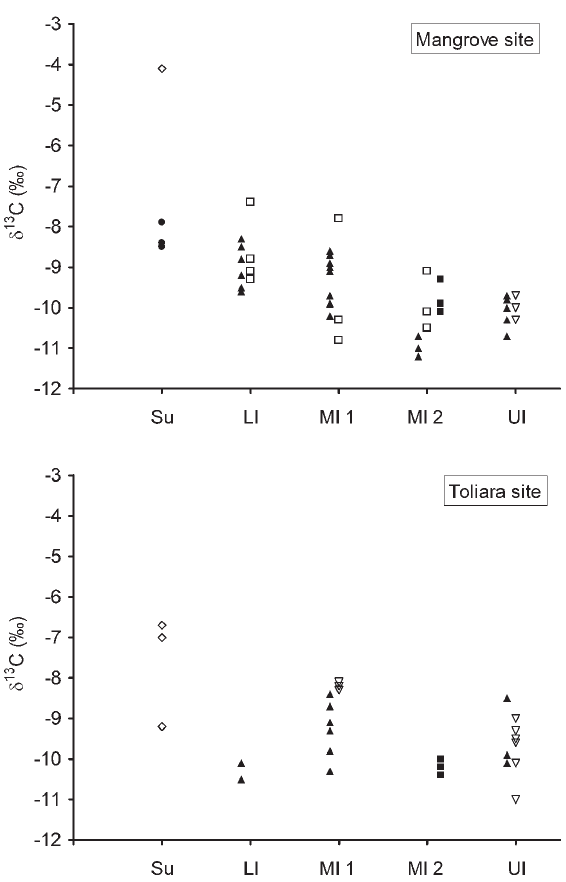
Fig . 4. – carbon isotope ratios measured in seagrass species col- lected on toliara Beach and Beloza mangrove (madagascar). (sub: subtidal; li: low intertidal; mi1: mid-intertidal community 1, mi2: mid-intertidal community 2; ui: upper intertidal). ¢ : Cymodocea rotundata , £ : Thalassia hemprichii , ò : Thalassodendron ciliatum , p : Halodule sp., s : Halophila ovalis, ◊ : Syringodium isoetifolium .